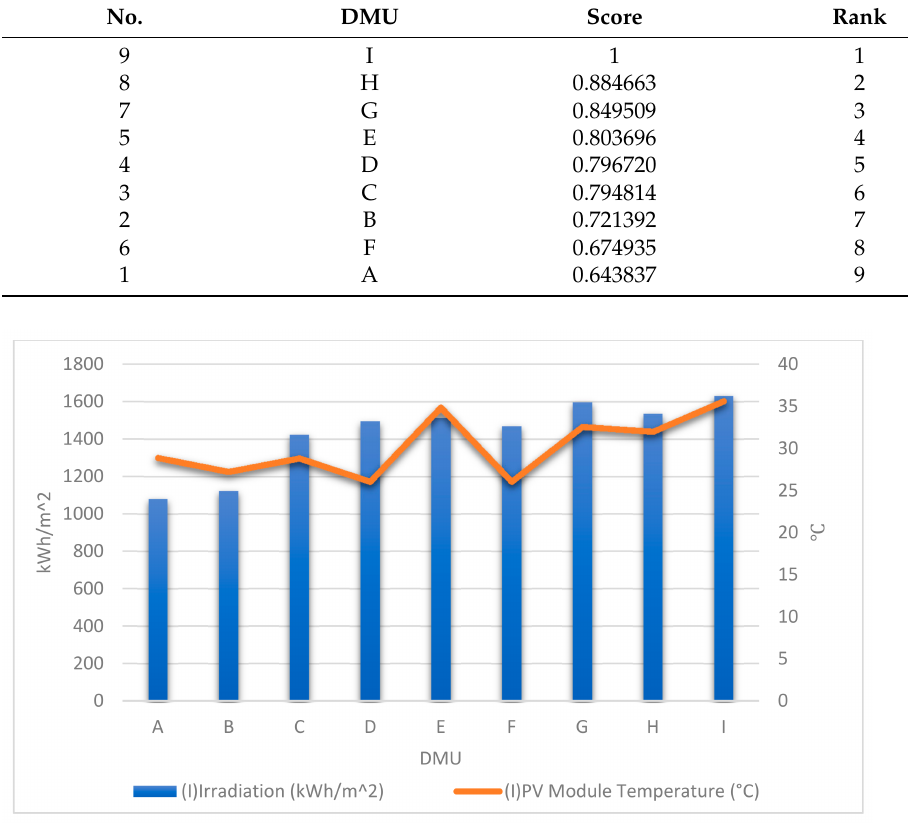
Table 8. Score and ranking of DMUs.